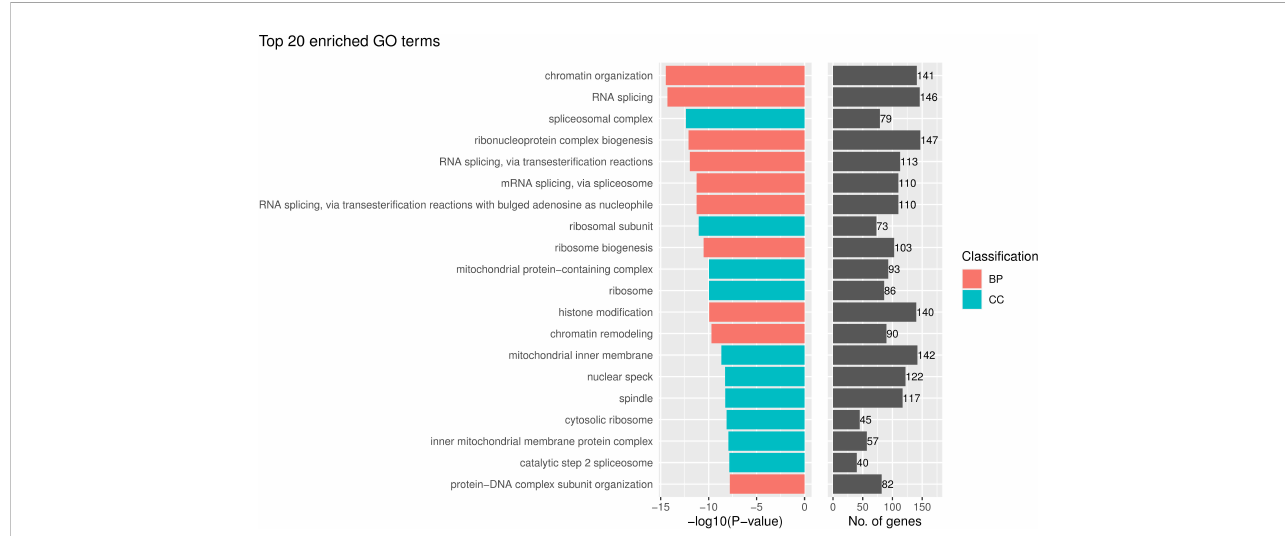
FIGURE 6 The top 20 gene ontology (GO) terms that were signi fi cantly enriched in the enrichment analysis for genes that are related to the prognostically signi fi cant features in the model without tumor